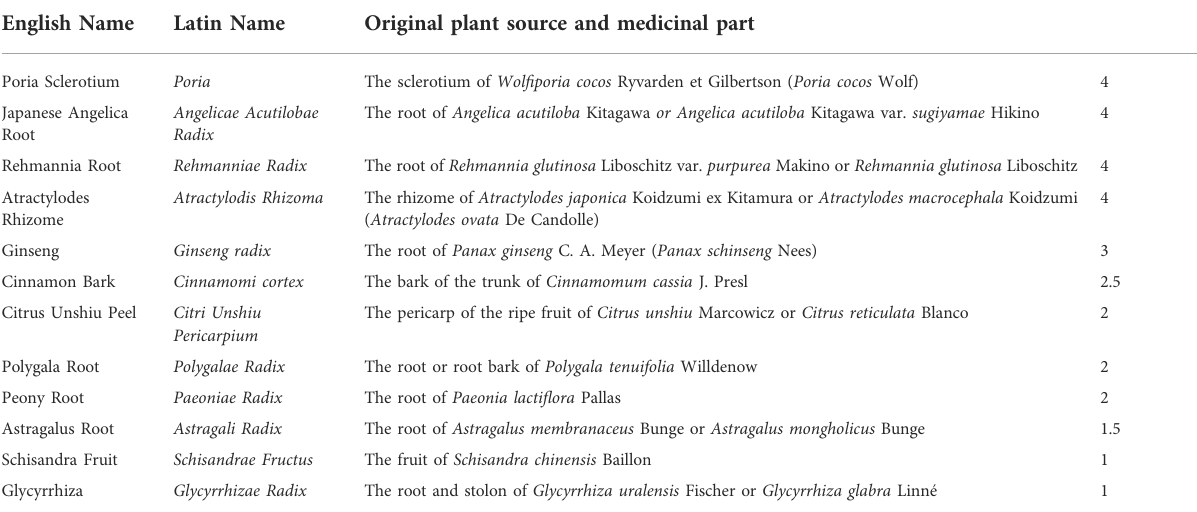
TABLE 1 Medical herb composition/daily amount of Ninjin ’ yoeito